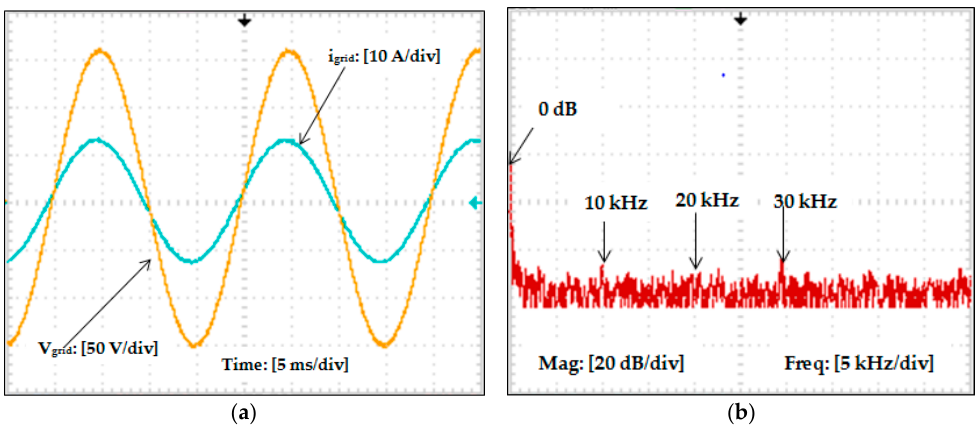
Figure 16. Experimental waveforms with Filter III: ( a ) output voltage and current waveforms; and ( b ) output current harmonic spectrum.